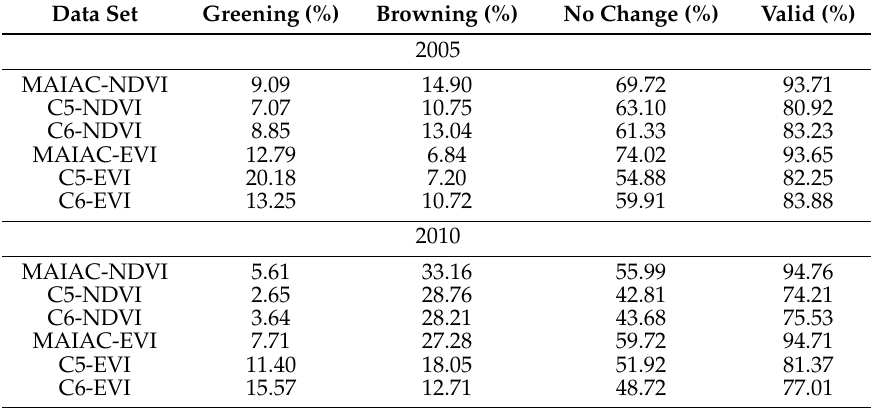
Table 1. Percentages of greening, browning, no-change, and valid areas within Amazon forests impacted by the 2005 and 2010 droughts, as shown by various remote sensing